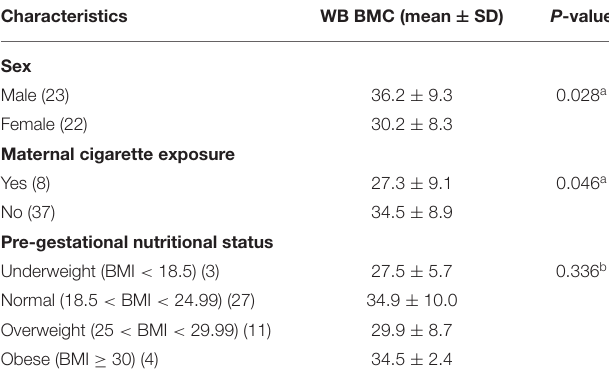
TABLE 3 | Mean of bone mineral content according to determinant